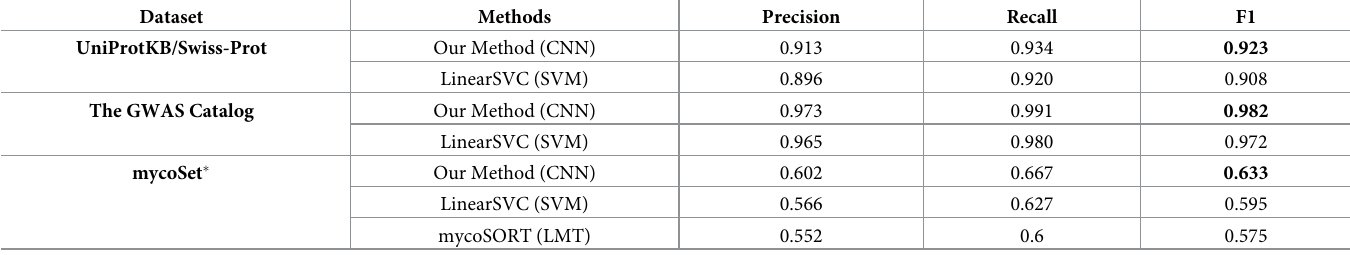
Table 1. Classification performance on UniProtKB, the GWAS Catalog and mycoSet. (CNN: Convolutional Neural Networks, SVM: Support Vector Machine, LMT: Logistic Model Trees). Dataset Methods